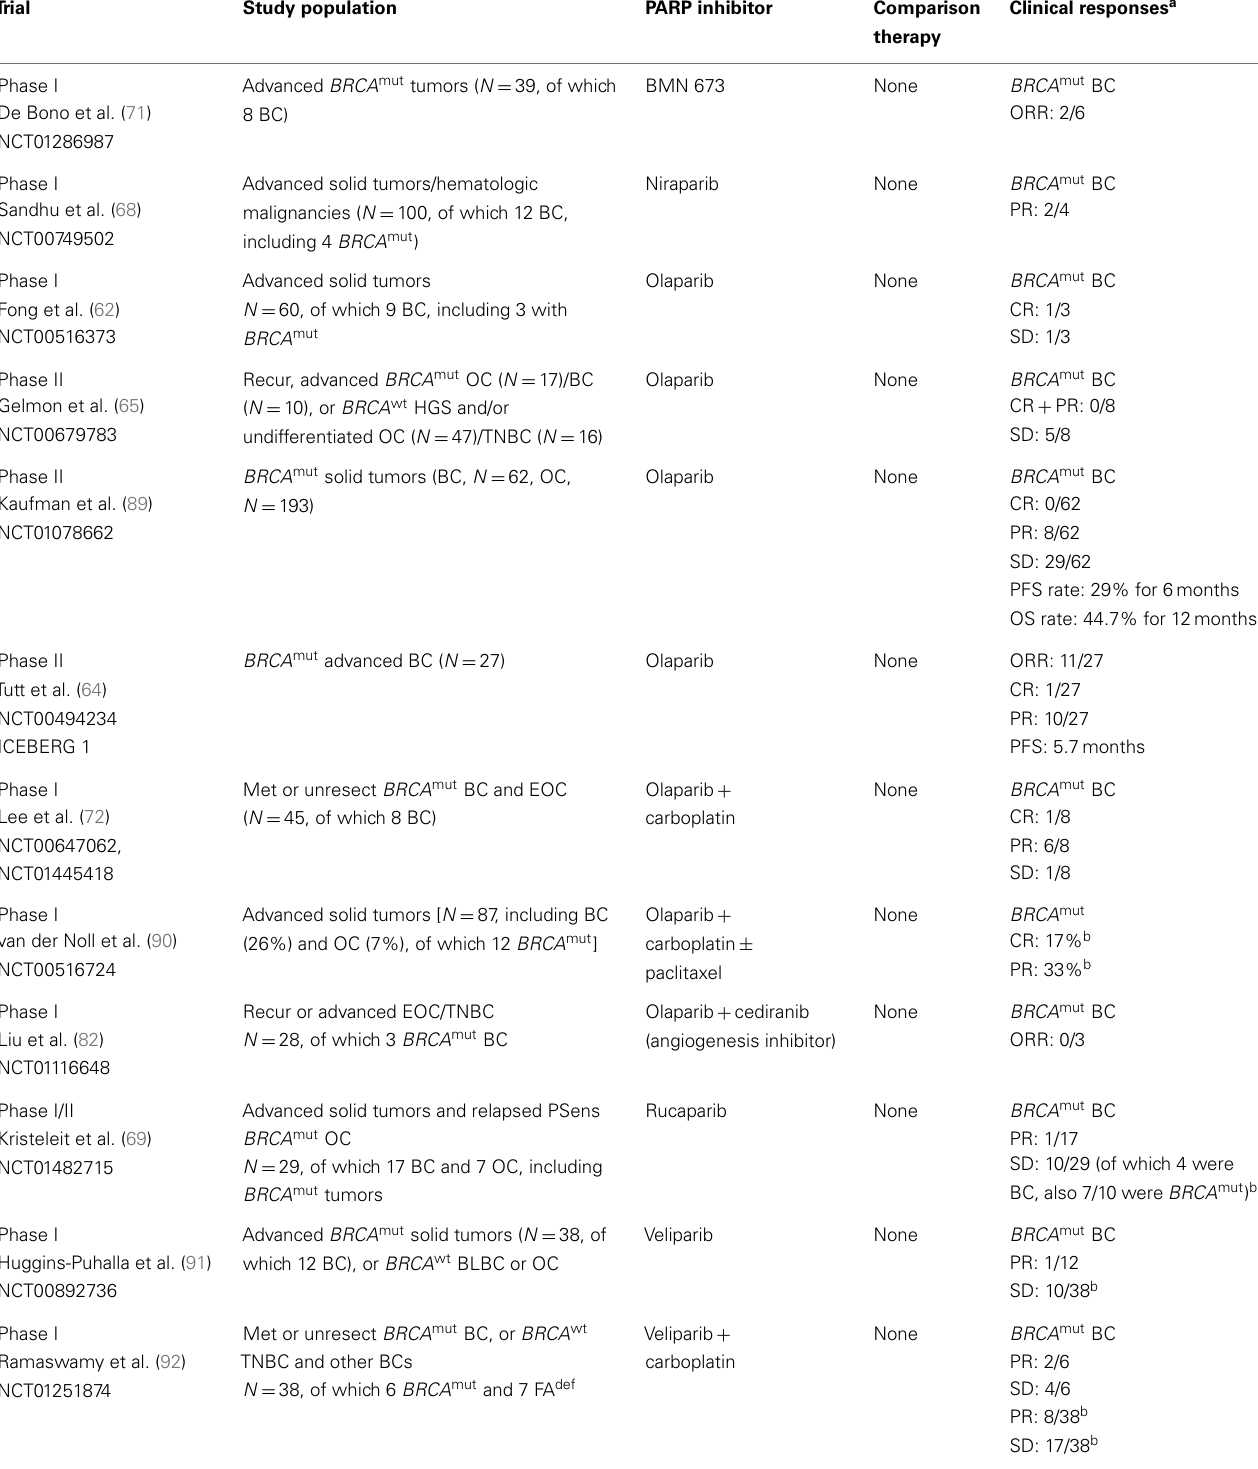
Table 1 | Selected PARP inhibitor trials in BRCA 1/2 -mutated ( BRCA mut ) breast